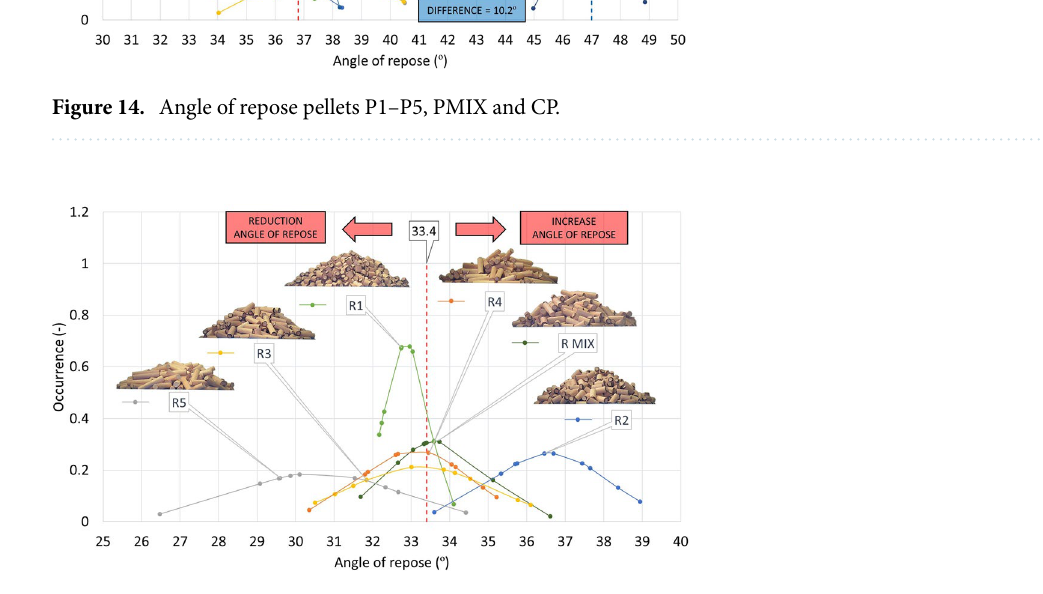
Figure 15. Angle of repose rods R1–R5 and